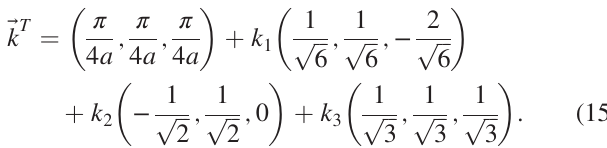
DW DW T=t ¼ 0 . 1 . The doping δ is B DW < 1 . When DW j